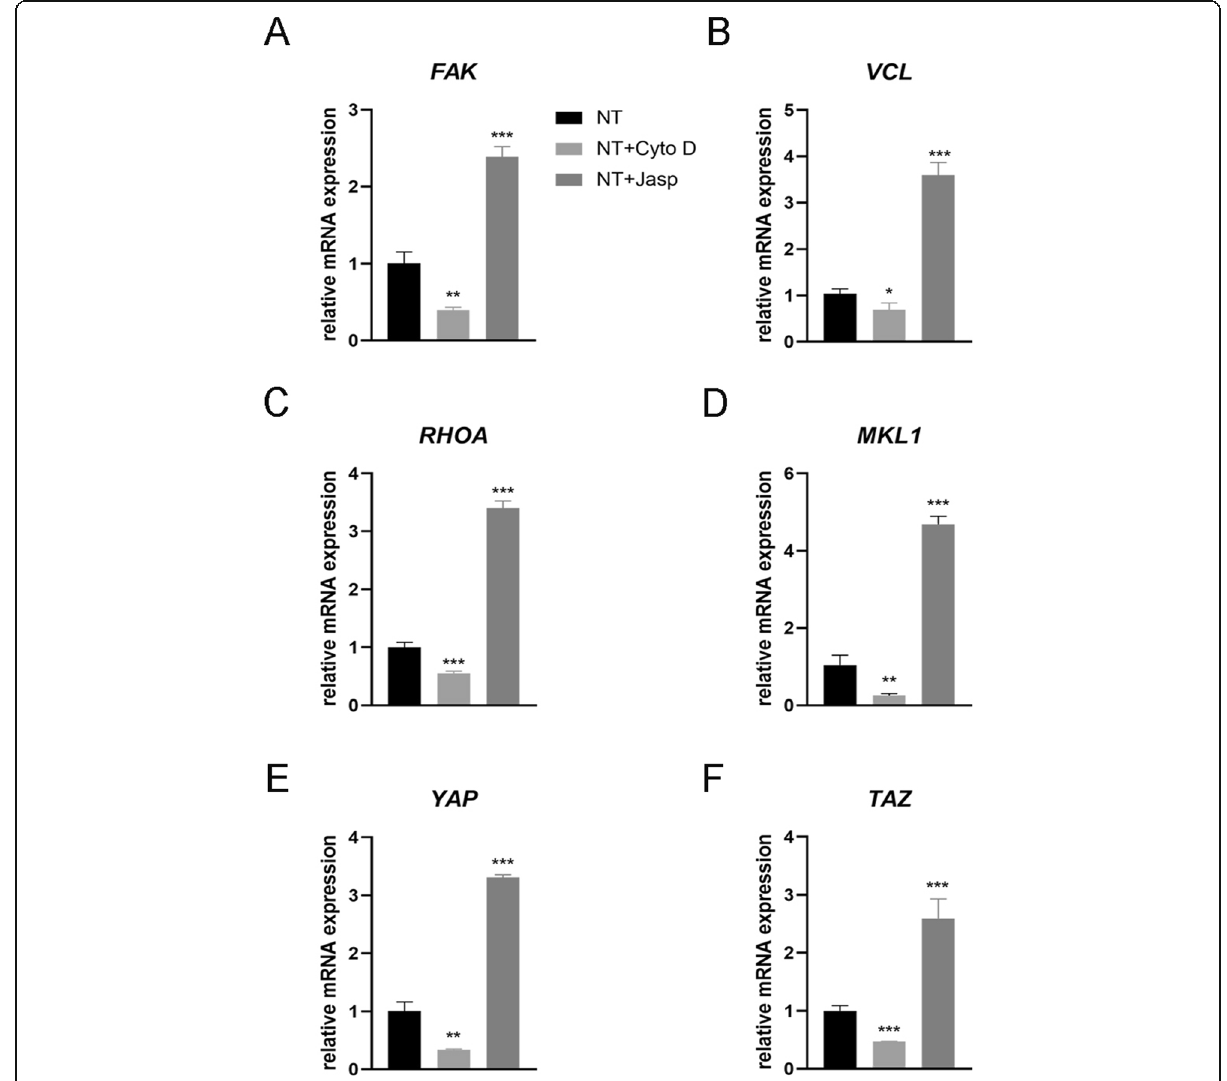
Fig. 6 Effect of F-actin assembly on FAK ( a ), vinculin (VCL) ( b ), RhoA ( c ), MKL1 ( d ), YAP ( e ), and TAZ ( f ) gene expression in MSCs. NT the nanotubes group. Data represent the mean ± SD of three samples. * P < 0.05, ** P < 0.01, and *** P <